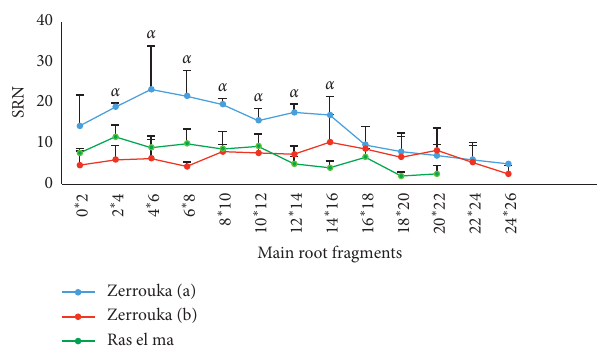
Figure 5: Variation in abundance of secondary roots (SRN) by fragment of the main root. 0 ∗ 2 means fragment 0 to 2 cm. The values marked with α indicate at least one significant difference at the fragment level ( P < 0 . 05, n �